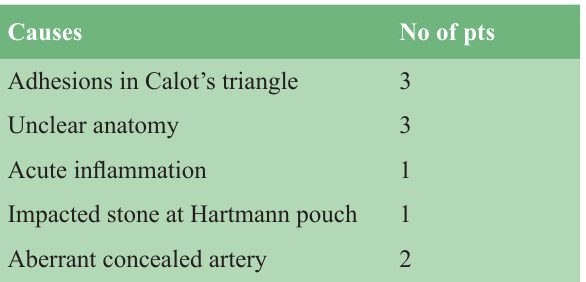
Table 2: Indications for conversion